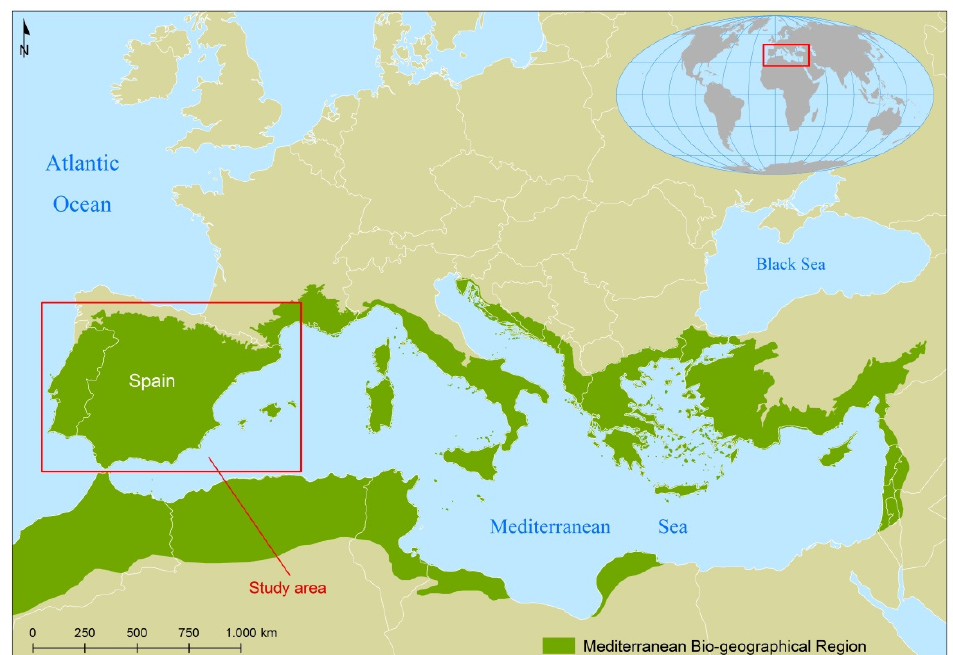
Figure 1. Mediterranean basin . Source: own elaboration.